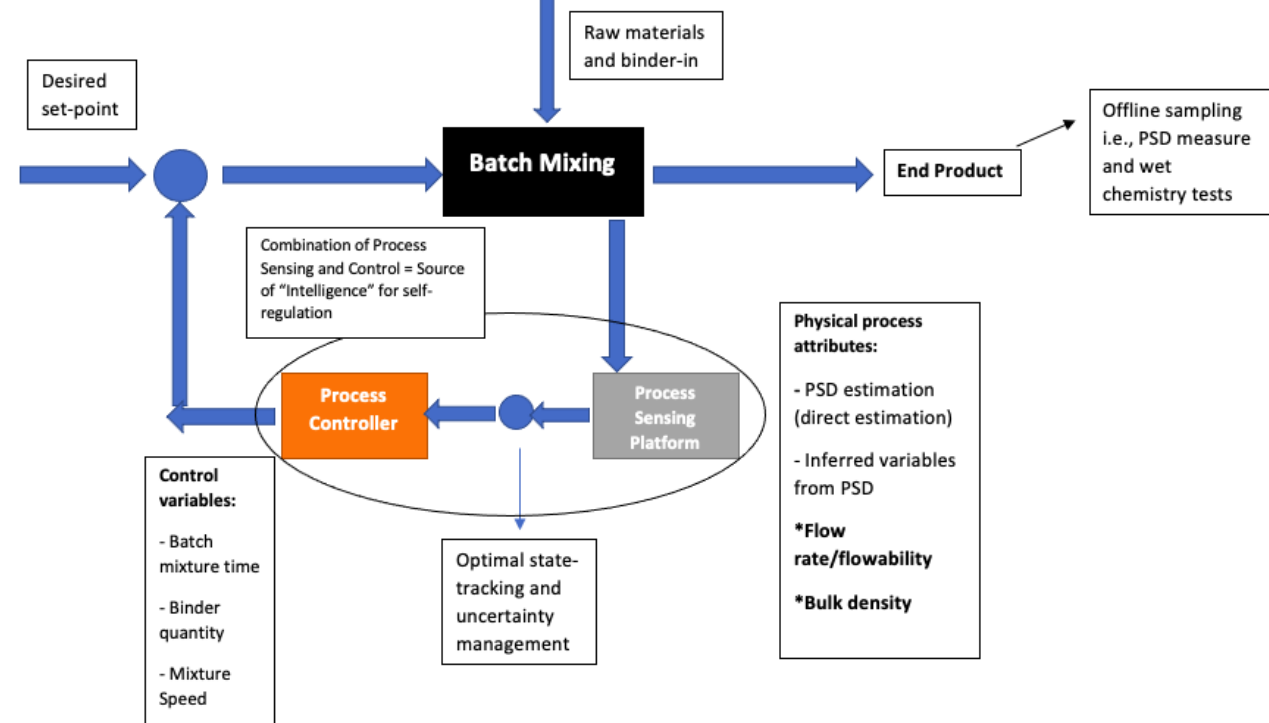
Figure 2. Proposed system diagram. * means the inferred variables.